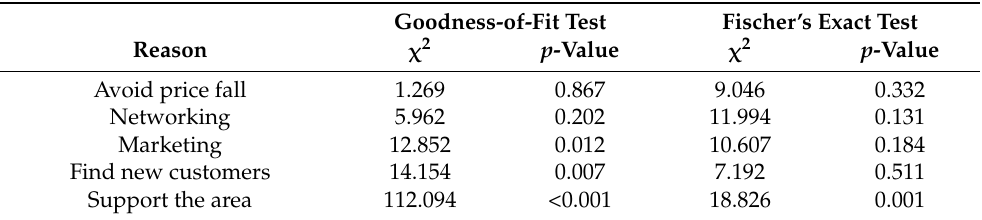
Table 2. Reasons for adhering to the system. Goodness of fit test: Comparison of grouped re- sponses from all respondents with expected uniform distributions of responses. Fischer’s exact test: Associations between organizations’ categories and reasons’ ratings. Significance set at a level of 0.05.